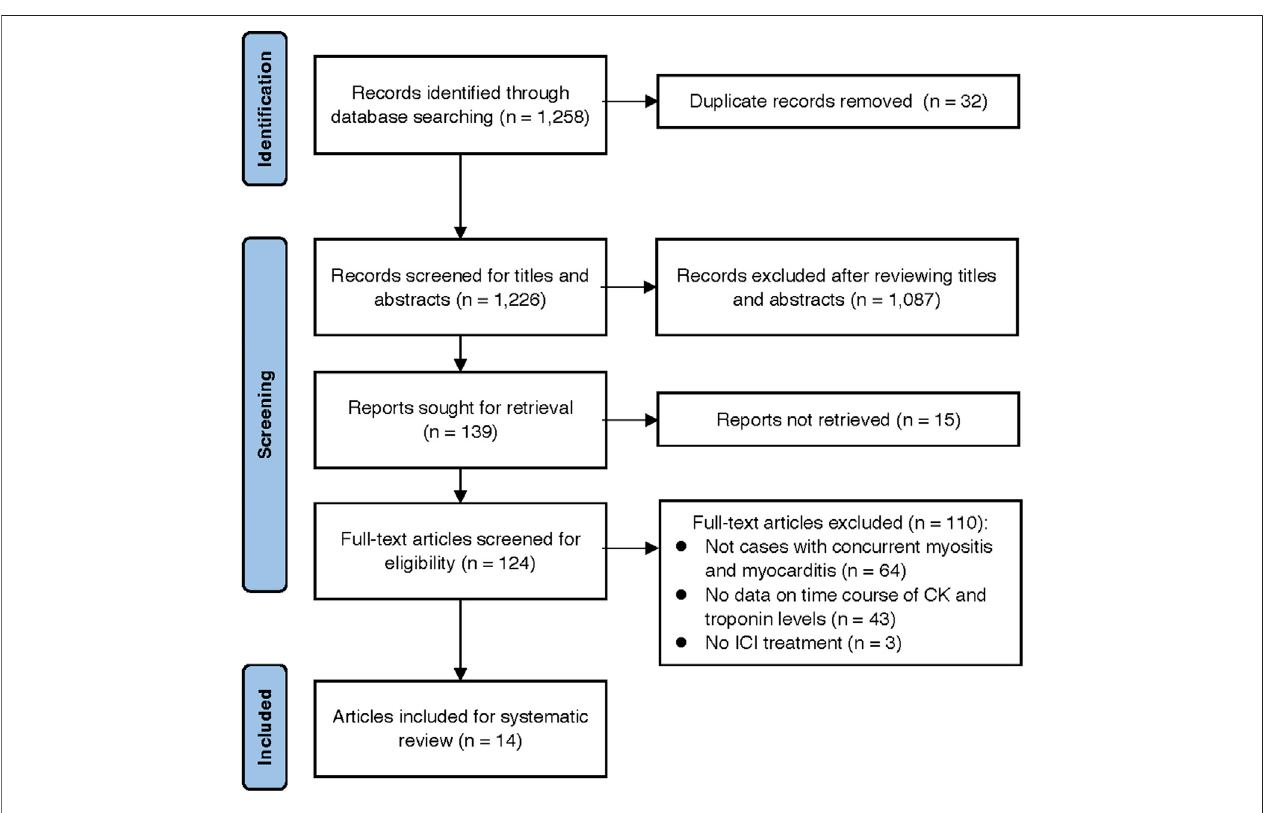
FIGURE 5 | Preferred Reporting Items for Systematic Reviews and Meta-Analyses (PRISMA) fl owchart of the study selection process.